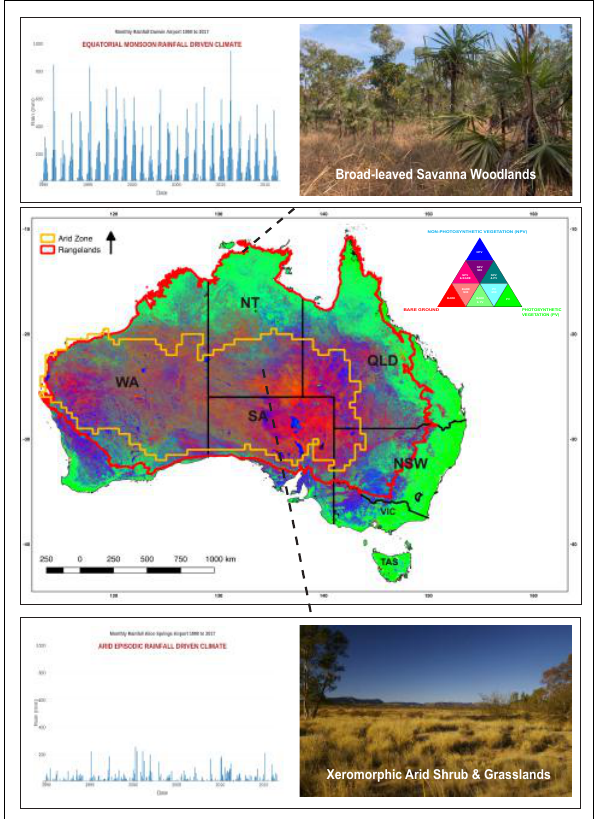
Figure 2. Extent of the Australian rangelands and its arid